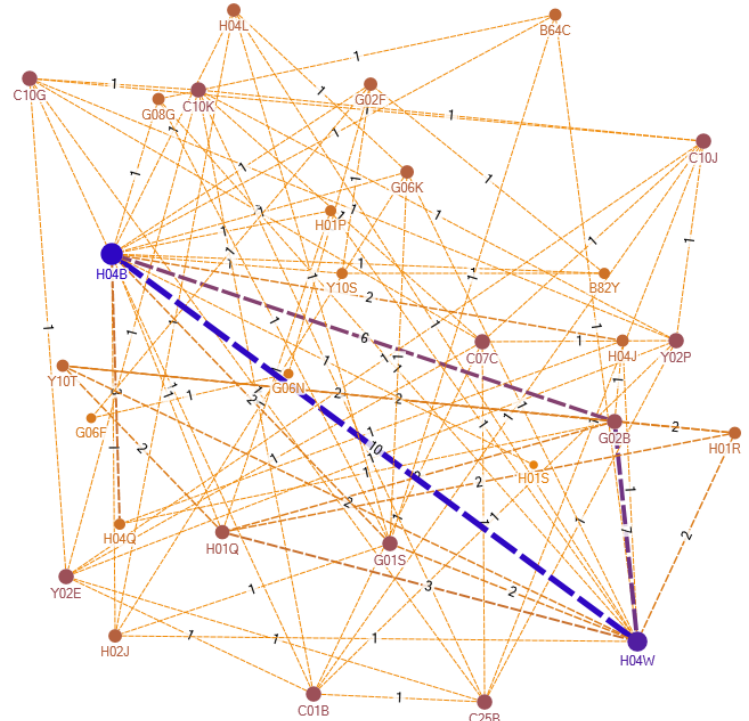
Figure 1. Third-order Cooperative Patent Classification (CPC) network diagram for 5G photonic technology. Note: The node size represents the number of nodes. The thickness of the arc represents the strength of the link and the number of